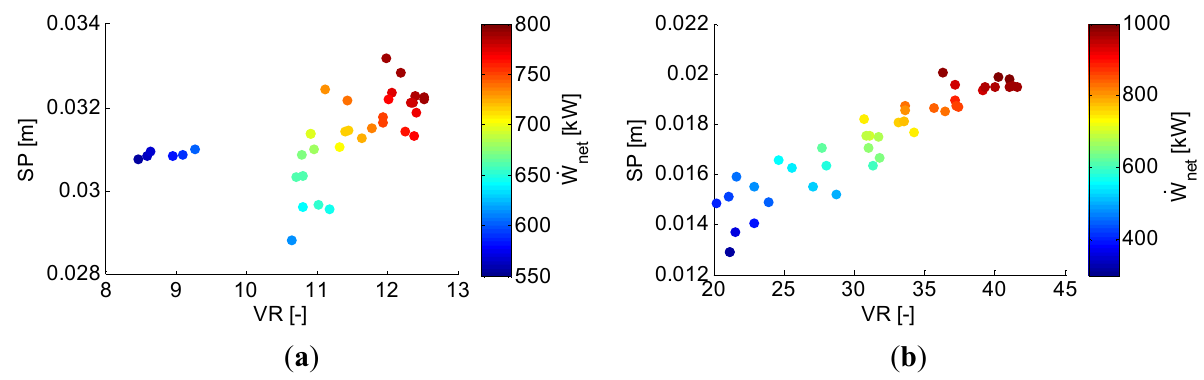
Figure 13. Size parameter (SP) and volume ratio (VR) for ( a ) SCORC and ( b ) TCORC.